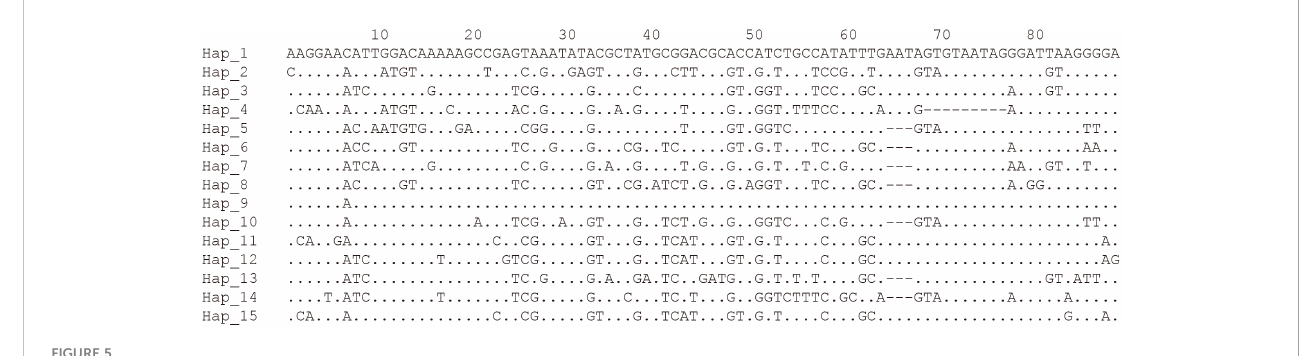
FIGURE 5 Haplotypes of the Rpb1 fragment of Neo fl abelliforma dubium n. sp. showing only the polymorphic